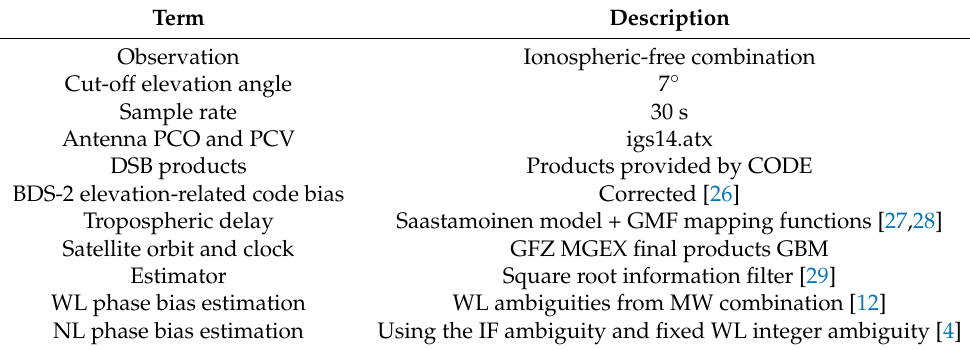
Table 3. Details of the data processing